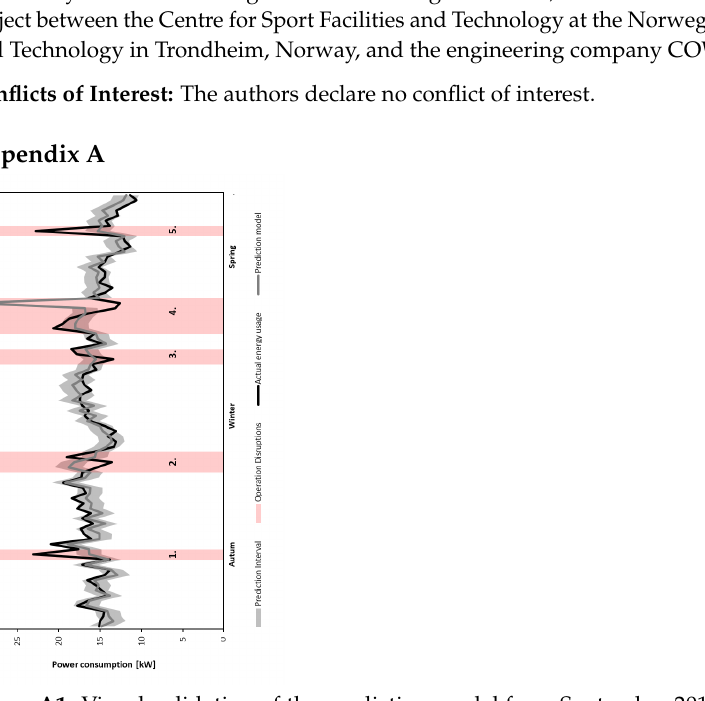
Figure A1. Visual validation of the prediction model from September 2018 to June 2019. The pre- diction model includes the prediction interval in gray, measured power consumption in black and periods associated with operational disruptions in